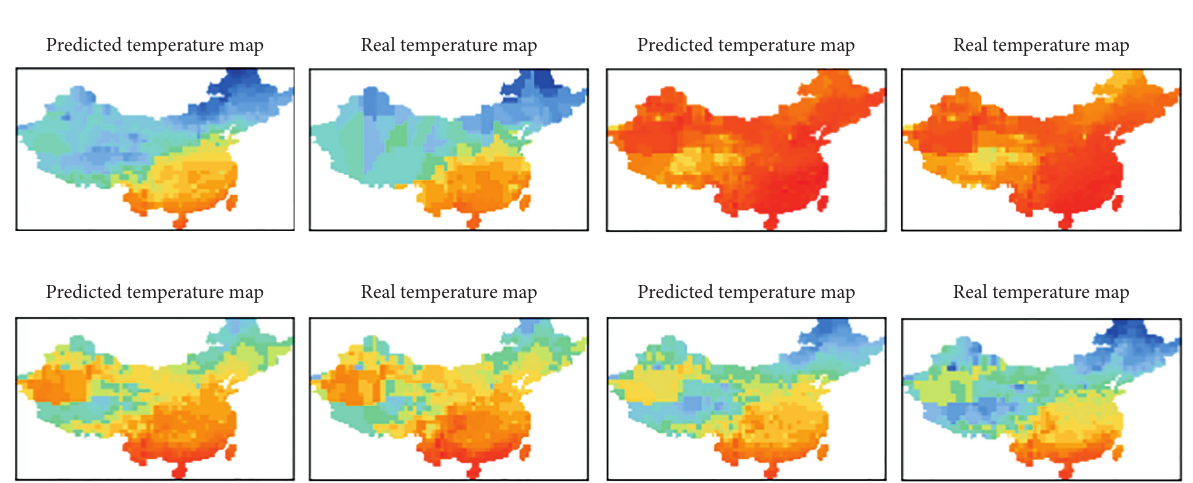
Figure 9: Visualized comparison figures between forecasting temperature data map and real temperature data